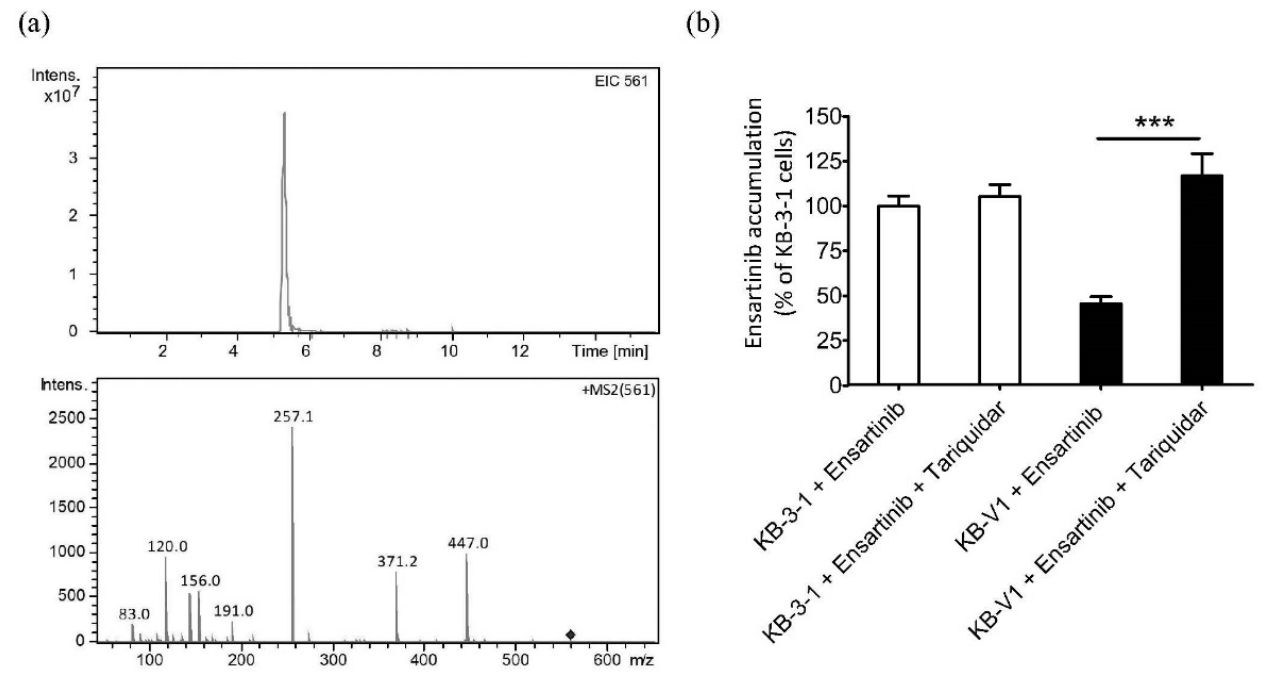
Figure 3. P-gp-mediated transport decreases the intracellular concentration of ensartinib in human cancer cells. ( a ) The chemical structure (precursor ion m/z 561 in positive mode) and the mass spec- tra of major fragment ions of ensartinib. The fragment ion m/z 371 was selected for quantitative analysis. ( b ) The intracellular accumulation of ensartinib in KB-3-1 (white bars) and KB-V1 cells (black bars) treated with 10 μM of ensartinib in the absence or presence of tariquidar was deter- mined as described in Materials and Methods. Quantitative data are presented as mean values ± S.D. calculated from three independent experiments. *** p < 0.001, as compared to treatment with tariquidar.